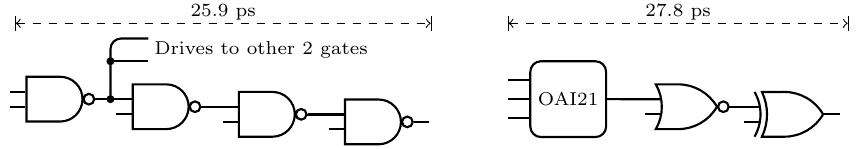
Figure 12: Critical path of the BipBipBox implementation in Verilog-HDL: (left) with optimized NAND logic and (right) with case statement of the substitution